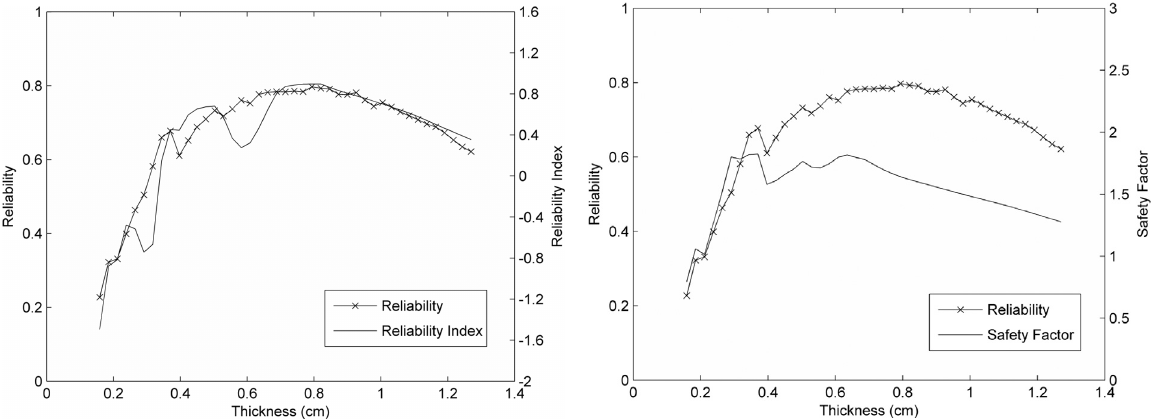
Fig. 14. Overlay of reliability index and Monte Carlo reliability vs. top plate thickness.